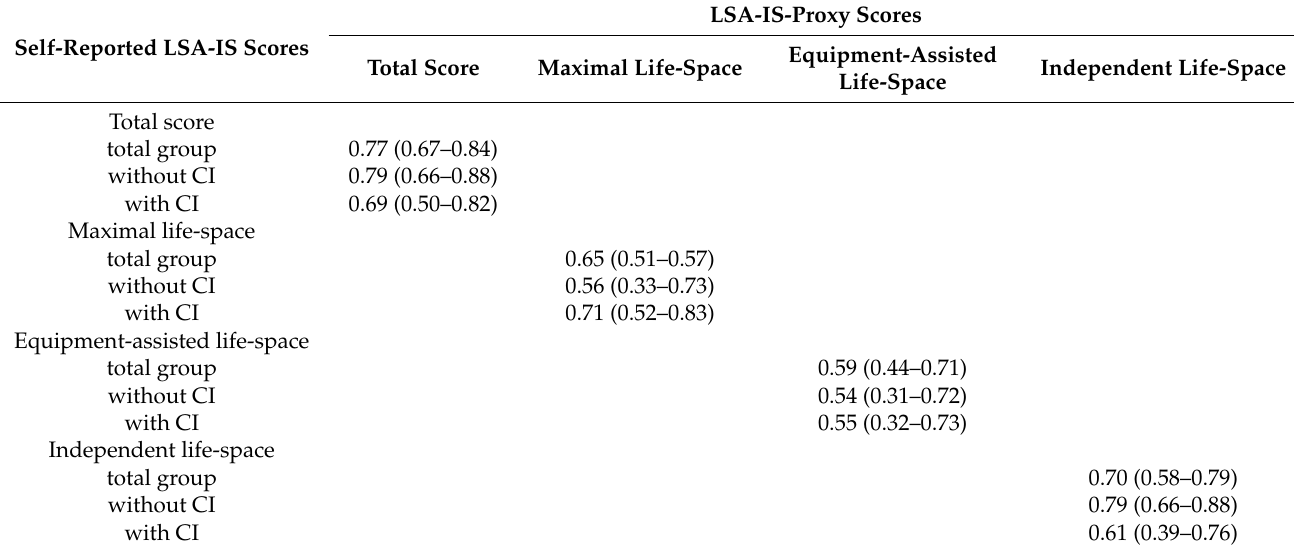
Table 2. Concurrent validity of the LSA-IS-proxy with the self-reported LSA-IS.